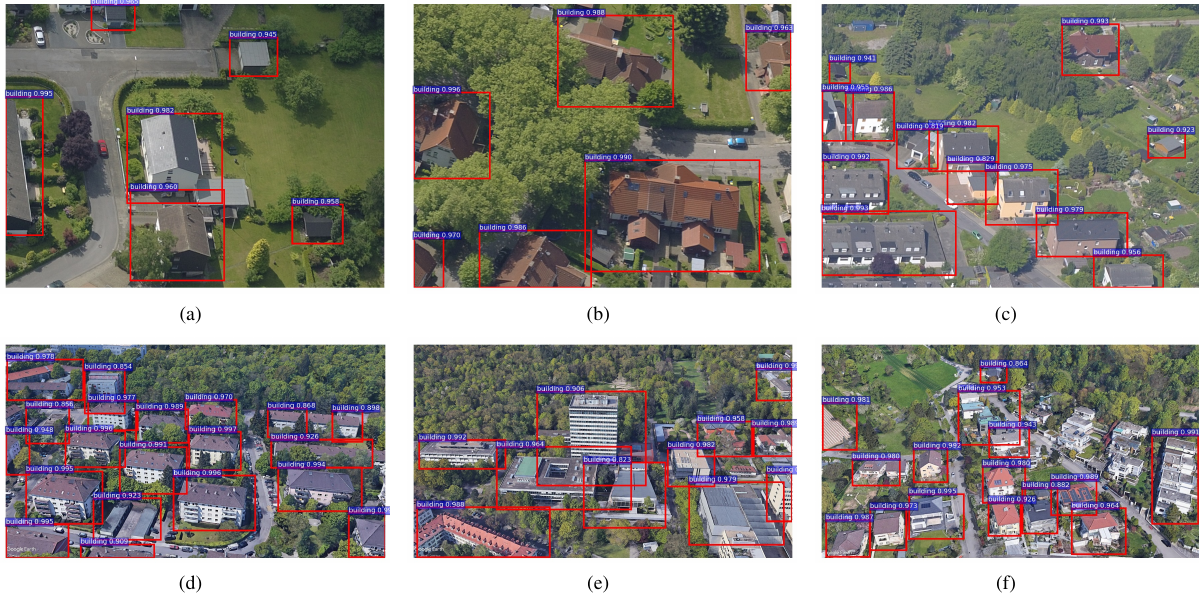
Figure 5. Excerpt of the qualitative results achieved by the Faster R-CNN trained with Conf3 . Figures (a), (b) and (c) depict results from the ISPRS dataset. Figures (d), (e) and (f) show an excerpt of the detection from the GoogleEarth dataset. Only detections with a confidence score > 0 . 8 are highlighted.